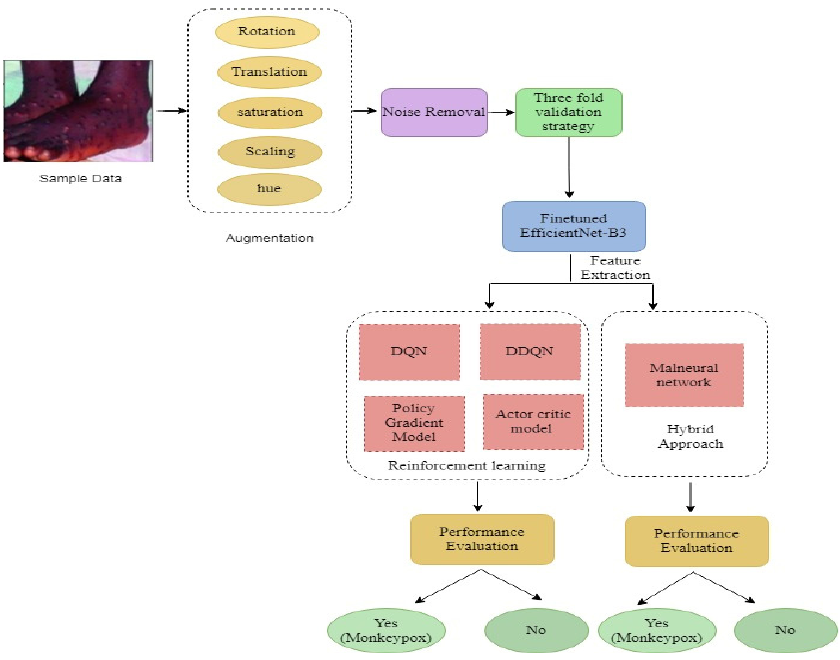
Figure 8. Proposed system framework.